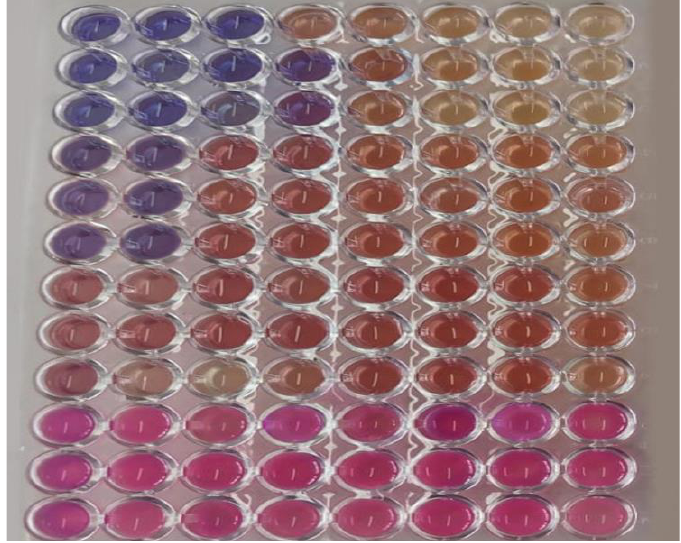
Figure 3. Antimicrobial activity of C. conduplicatus essential oil relieved by the addition of 0.01% resazurin solution. Each set of three lines on the plate represents a tested microorganism, with the following strains: methicillin-sensitive S. aureus (MSSA), methicillin-resistant S. aureus (MRSA), Escherichia coli and Pseudomonas aeruginosa , respectively. Table 3. MIC/MBC or MFC of C. conduplicatus essential oil.